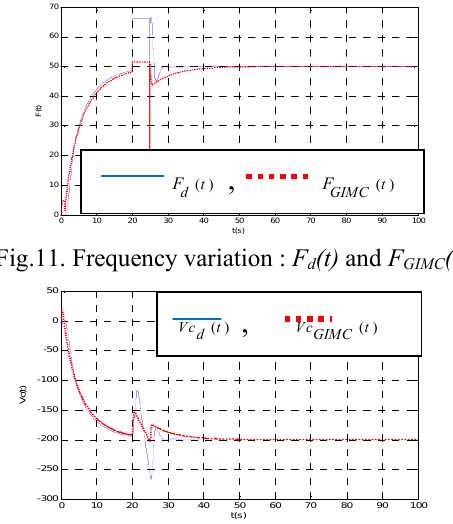
Fig.12. Loop control